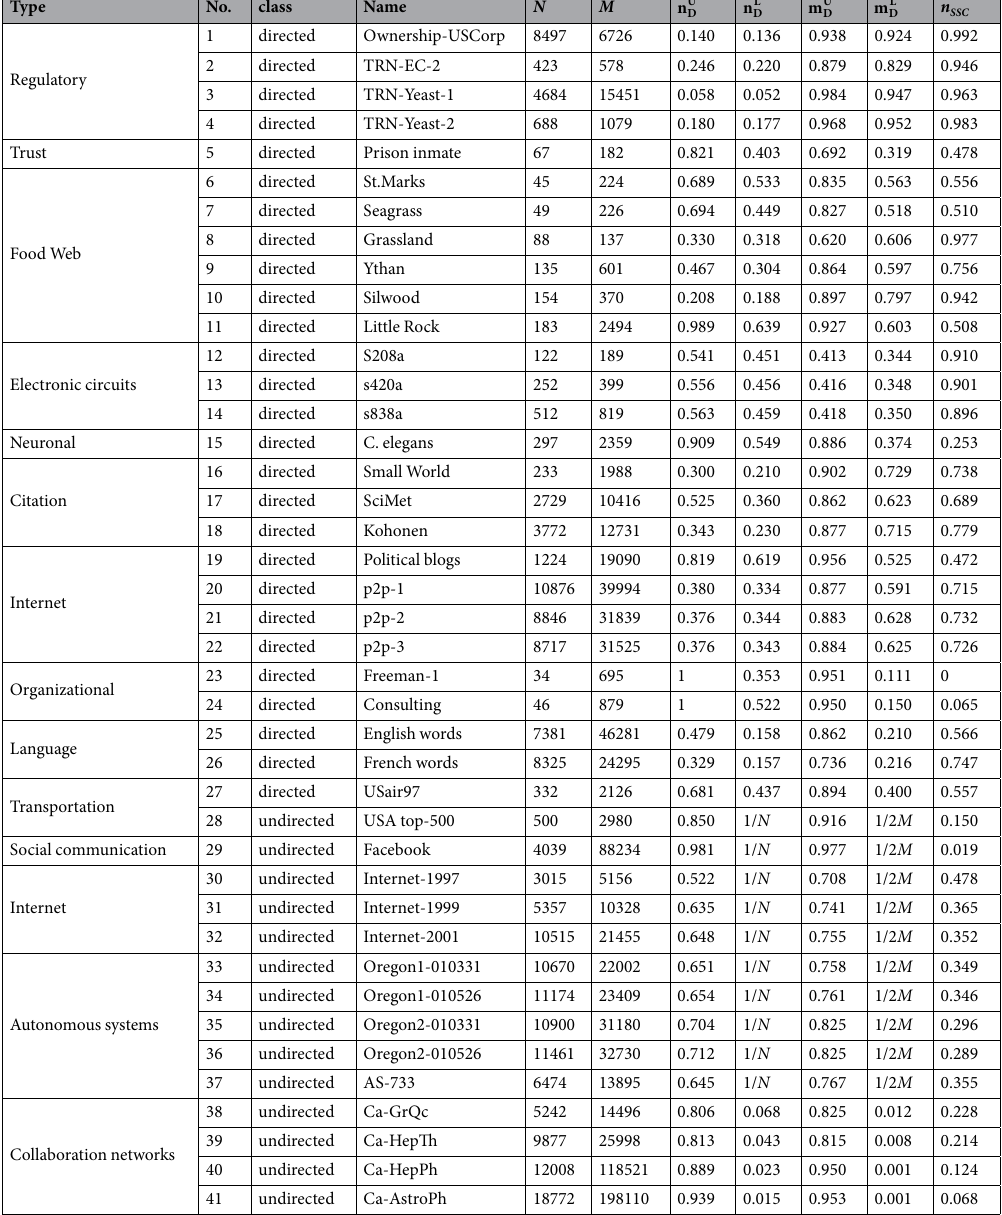
Table 3. Controllability of edge dynamics in real networks. For each network, its type, class, name, number N of nodes, number M of edges, the upper bounds ( n DU and m DU ), the lower bounds ( n DL and m DL ), and strong structural controllability measure n ssc are shown. For data sources and references, see Supplementary Table